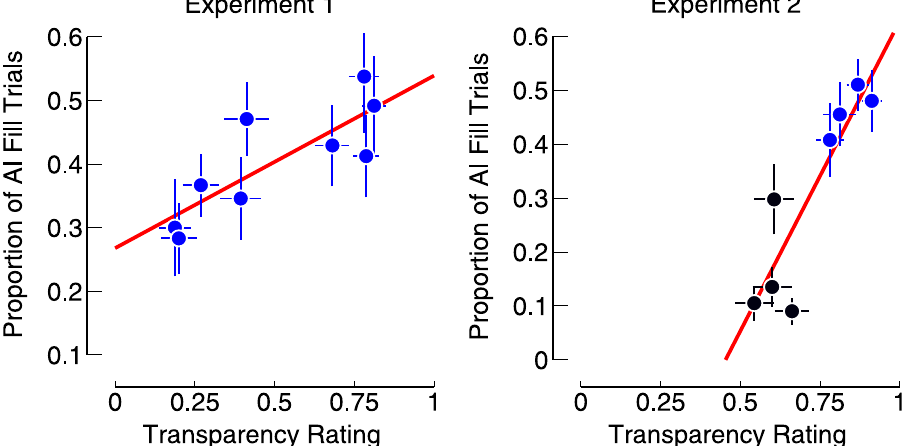
Figure 3. Correlation between transparency ratings and afterimage completion. Each dot represents one of the conditions tested in each experiment, and is the mean ( ± s.e.m.) over subjects for both the transparency rating, and the afterimage completion. For experiment 2, the blue dots show the data for the conditions similar to Fig. 2A, and black dots show the data for the conditions similar to Fig.